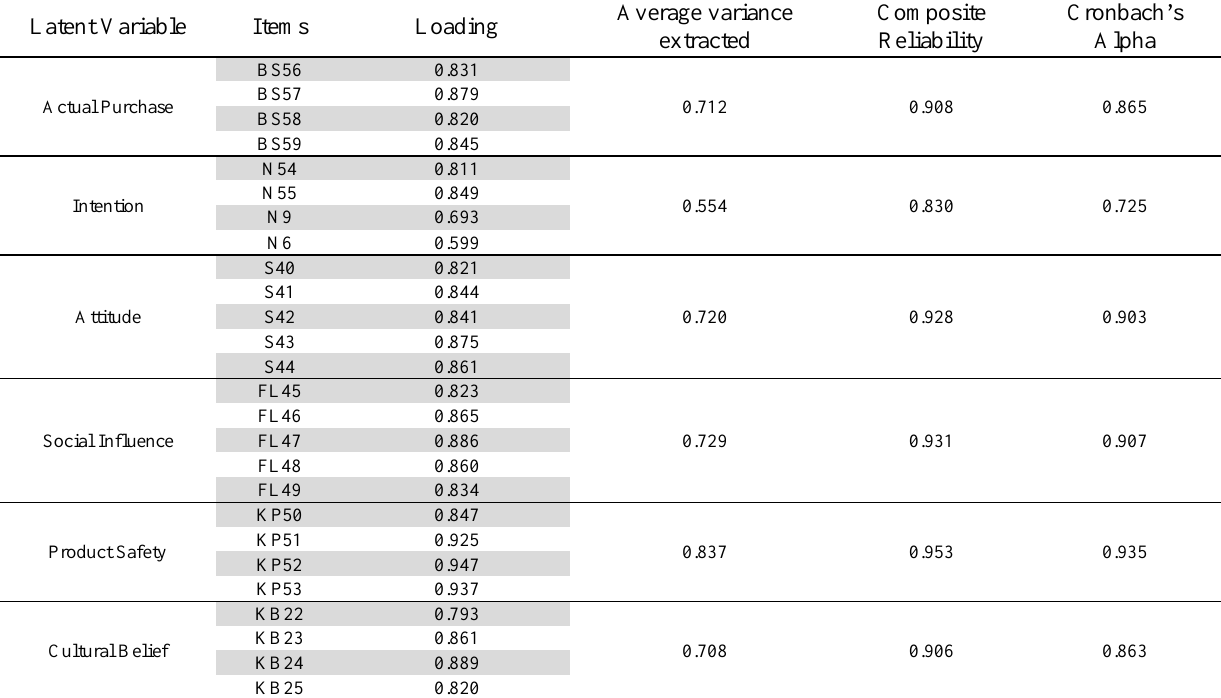
Results of measurement model